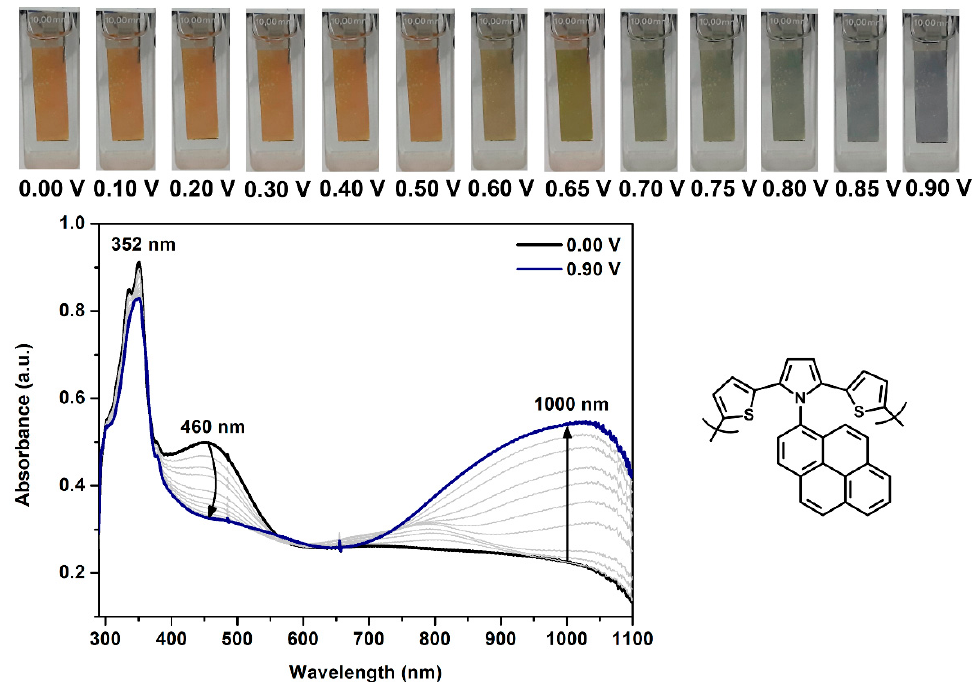
Figure 10. Spectroelectrograms, color changes and transmittance changes of P1 thin films on ITO-coated glass in 0.1 M Bu 4 NClO 4 / MeCN at various applied voltages.